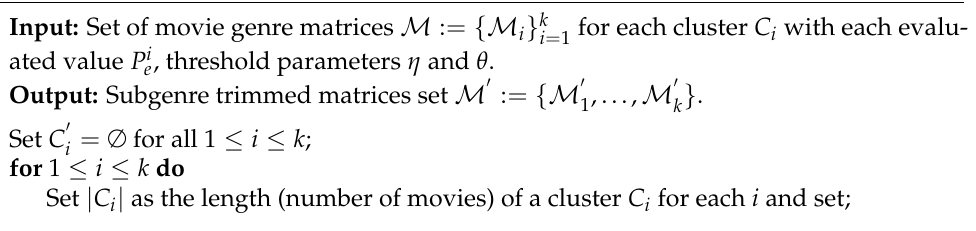
Algorithm 1 Subgenre